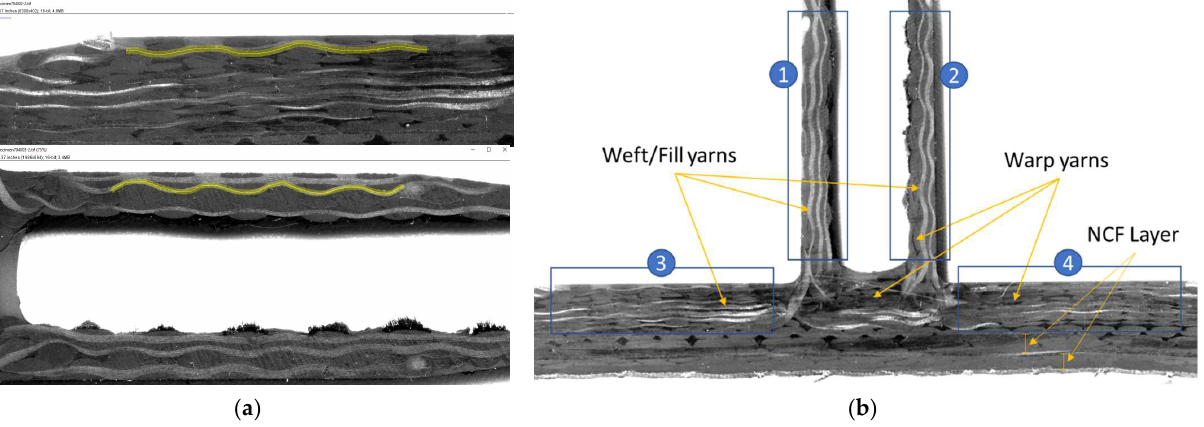
Figure 5. ( a ) Example of tracing tool for measuring yarn paths in ImageJ; ( b ) Cross-sectional image of Pi-NCF component labelling warp and weft yarns, NCF layers, and crimp measurement zones.